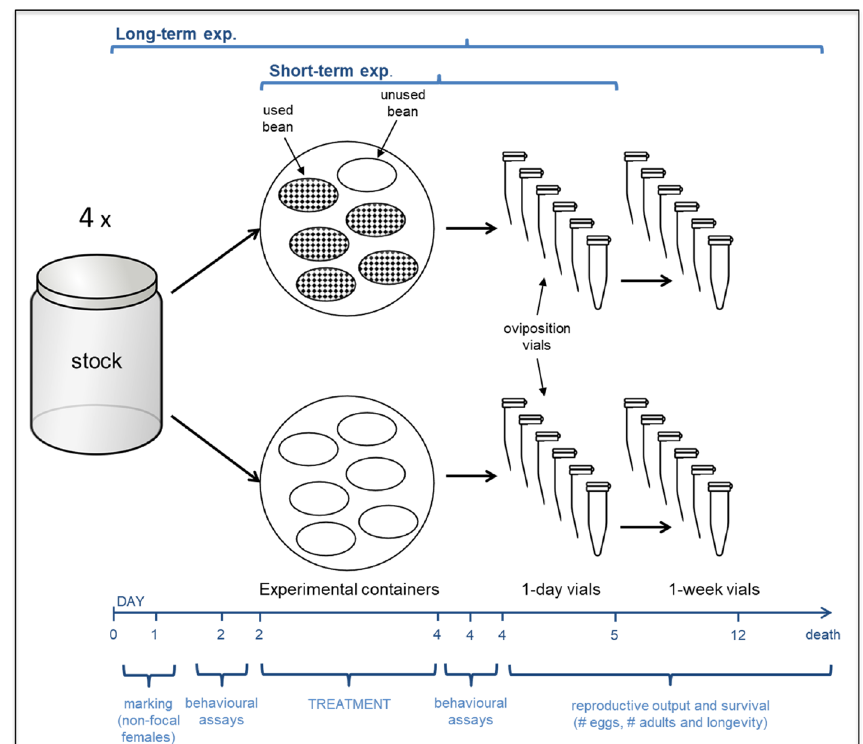
Figure 1. Schematic overview of the experimental setup. Callosobruchus maculatus females were exposed to either restricted or unrestricted resources for oviposition early in life. For simplicity only six beans are shown in each experimental container. In the long-term experiment we focused on long-term reproductive investments, as well as on behaviour and longevity. In a short-term experiment, we focused on reproductive investment during the treatment phase (as this could not be measured in the long-term experiment). The short-term experiment was a simplification of the long-term experiment: it ended on 1-day vial and no behavioural assays were conducted before and after the treatment. The experimental procedure of the long-term experiment was repeated four times (samples sizes per treatment for each experimental block are indicated in Table 1). For details of the protocols see main